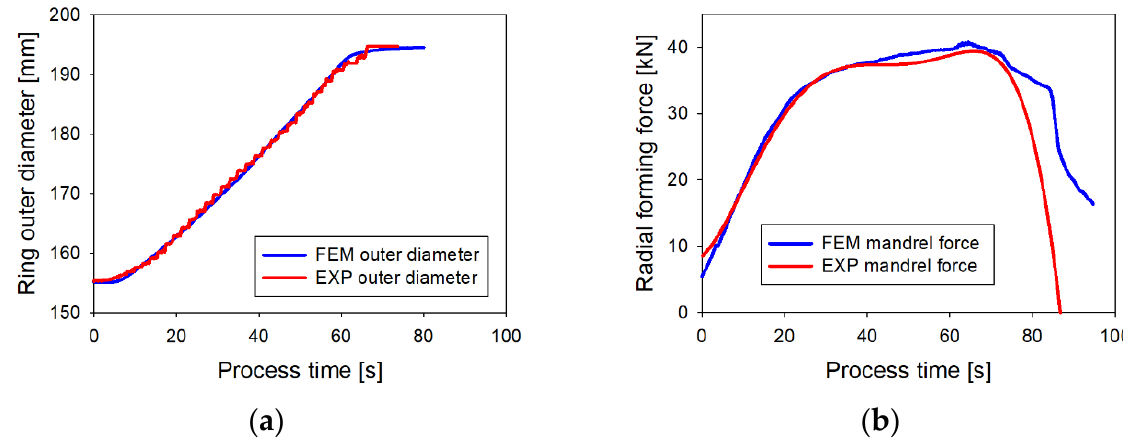
Figure 5. Comparison between the experimental and finite element ( a ) ring outer diameter and ( b ) radial forming force for the Pb75-Sn25 validation ring.